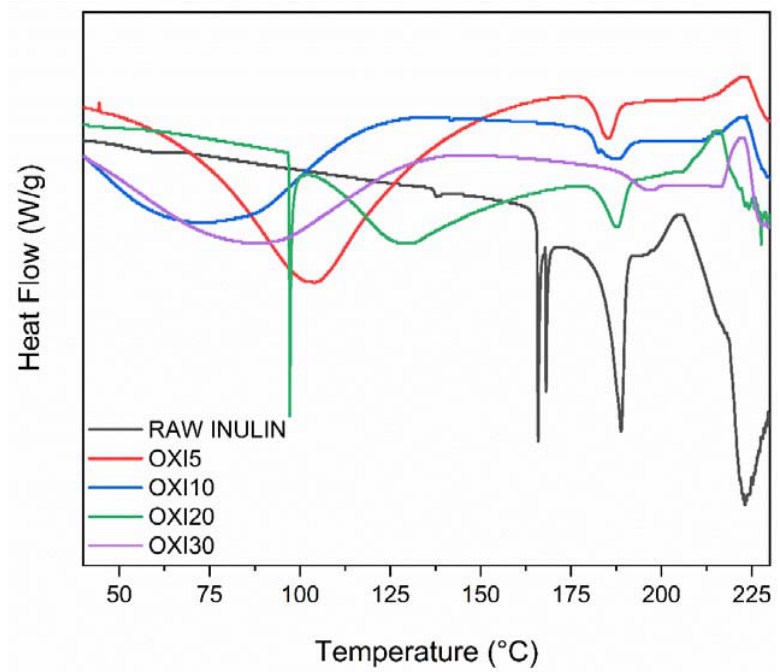
Figure 7. Differential scanning calorimetric (DSC) of raw inulin and all the modified inulin samples. Figure 7. Di ff erential scanning calorimetric (DSC) of raw inulin and all the modified inulin